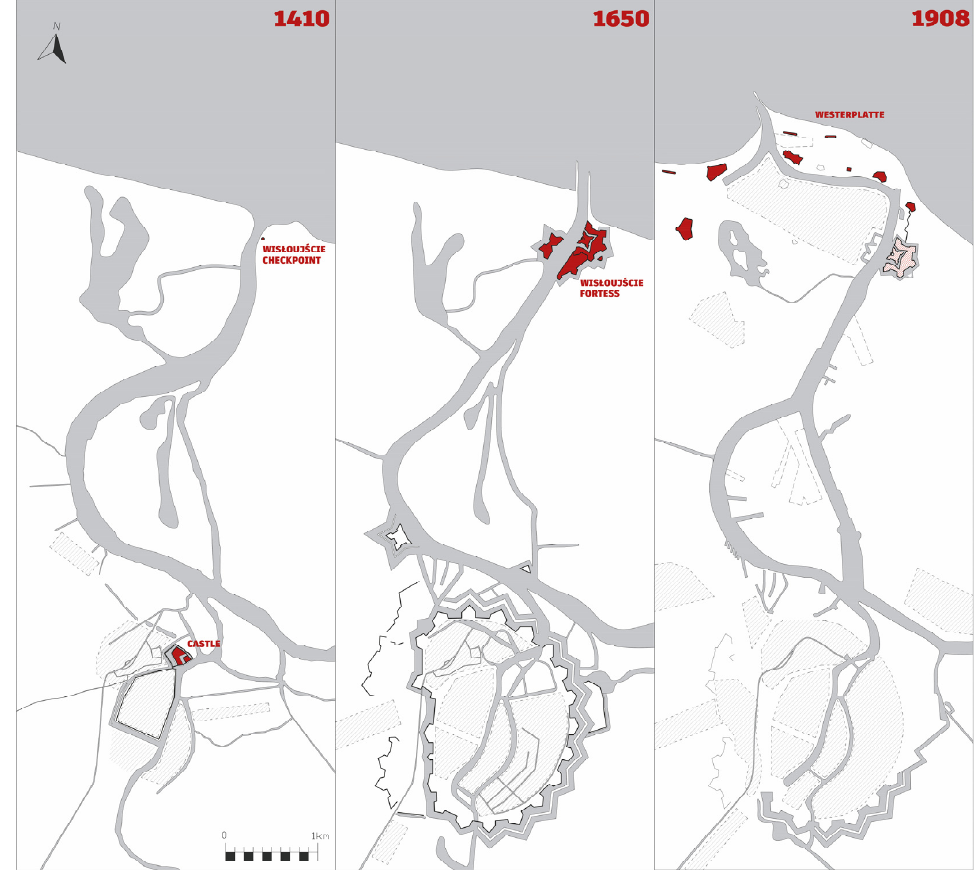
Figure 3. Scheme of the Gdansk city’s development along with its direct protection of the port’s entry.